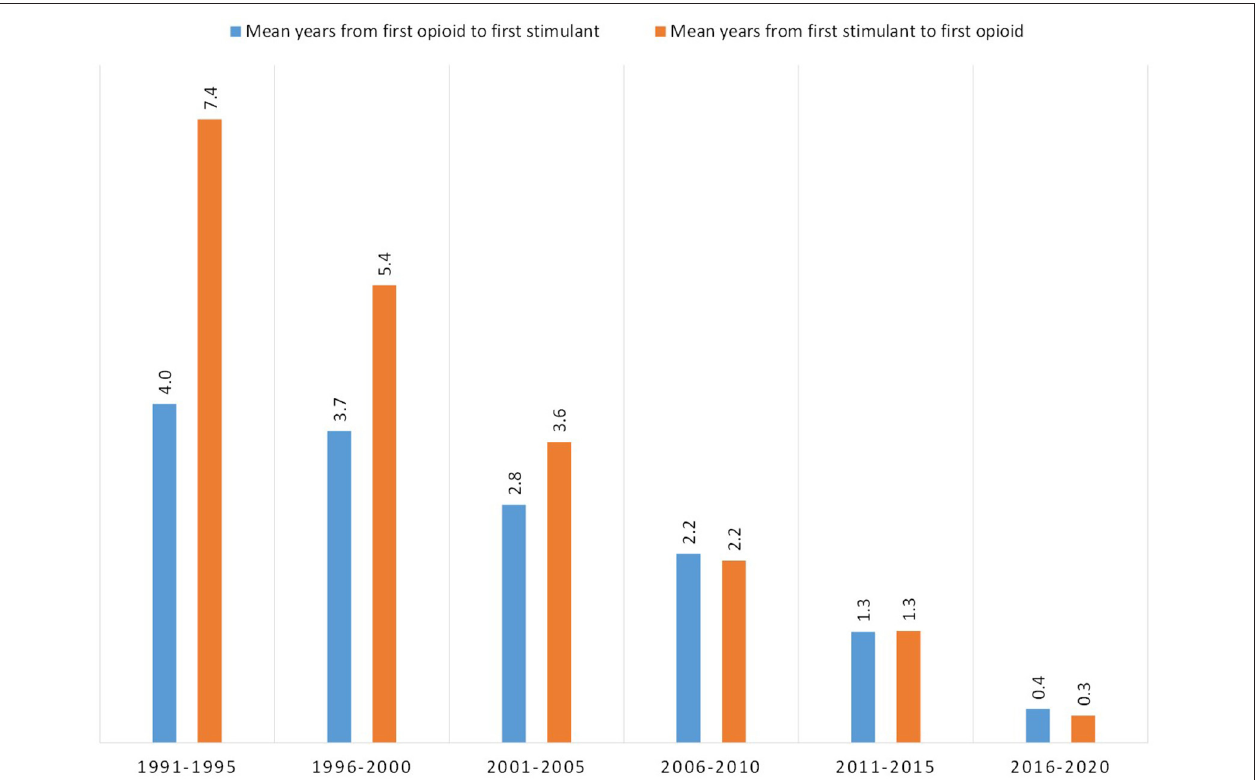
FIGURE 7 | Mean number of years between first use of an opioid and first use of a stimulant, or first use of a stimulant and first use of opioid, grouped by year of initial drug exposure.